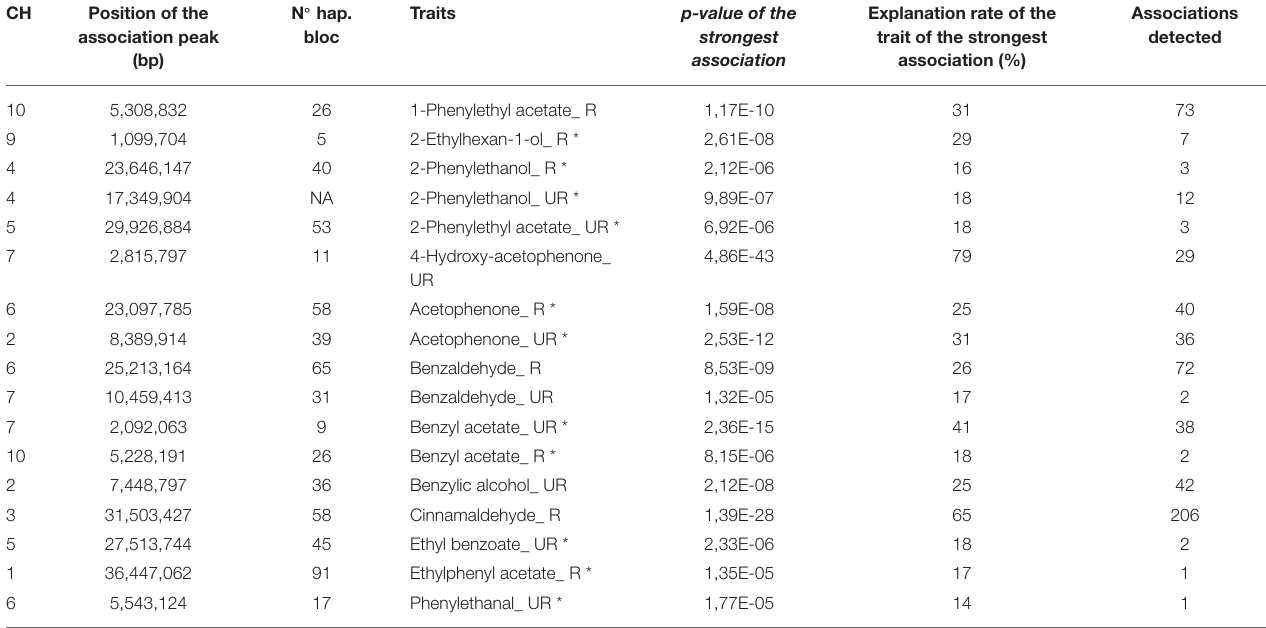
TABLE 4 | Most significant associations for biochemical compounds related to L-phenylalanine degradation pathway. N ◦ hap. CH Position of the association peak (bp)